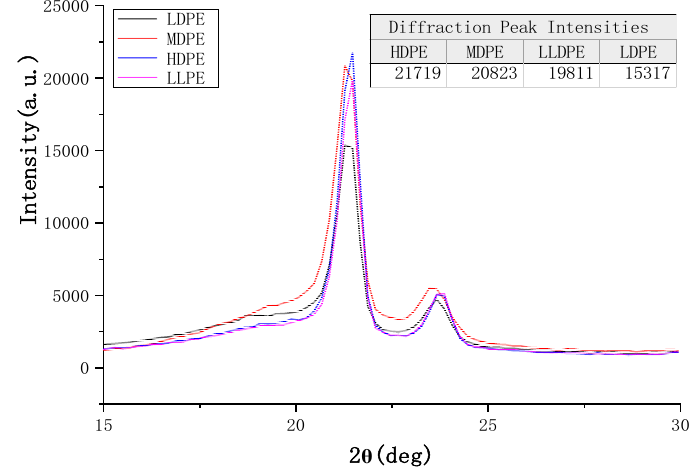
Figure 3. X-ray di ff raction (XRD) images of four kinds of polyethylene. Figure 3. X-ray diffraction (XRD) images of four kinds of polyethylene.